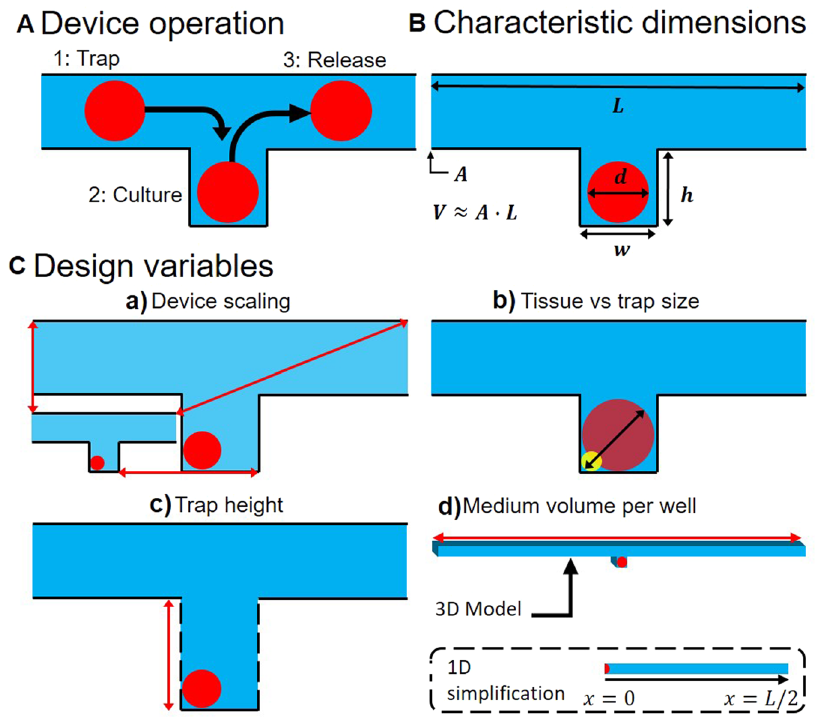
Figure 2. MST simulation methodology: ( A ) Sample traps operation schematic: (1) trapping of a tissue, spheroid or cell suspensions using any trapping mechanism (typically with volume forces), (2) culture, growth, treatment and in - vitro analysis of the tissues, and (3) release, ejection or collection of the samples from the traps for external analysis (e.g. flow cytometry). ( B ) Characteristic dimensions of the device with: L the inter- well separation, A the channel cross-section, V the available medium volume per well, d the tissue diameter (assuming a spherical tissue), w the well size (assuming a square well) and h the well depth. ( C ) Degrees of freedom for designing the device: (a) scaling the device up and down while keeping the tissue size constant compared to the well size, (b) scaling the tissue size while keeping all other dimensions constant, (c) scaling the trap height while keeping all other dimensions constant, and (d) scaling the available medium volume per well while keeping all other dimensions constant (inset shows the 1D simplification of the device for analysing diffusion of